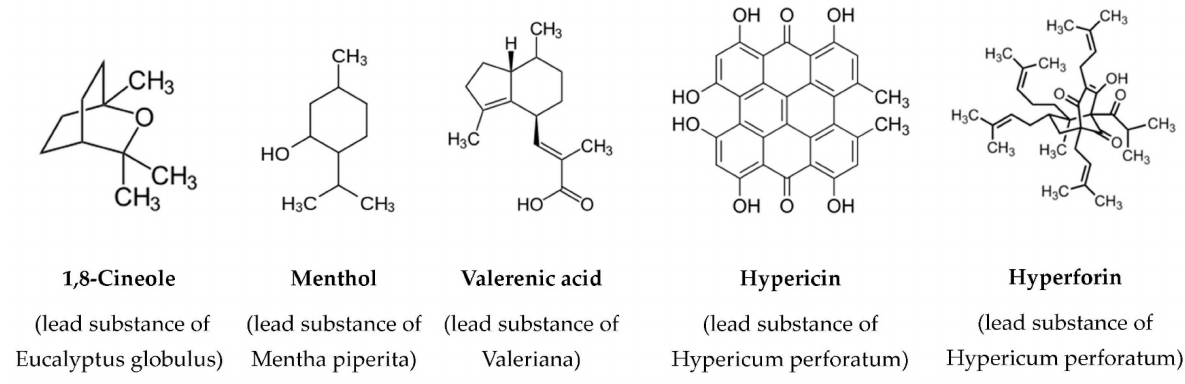
Figure 1. Chemical structures of lead substances of assessed